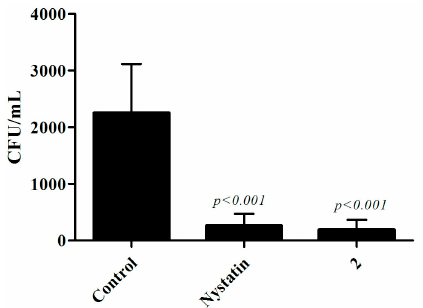
Figure 6. Murine model treatment of oral candidiasis. The number of colony-forming units (CFU) recovered from the tongues of C57BL/6 females infected with C. albicans CAN14 was lower in the nystatin (600 IU) and thiazolylhydrazone derivative 2 (100 mg/kg) treated animals than in the untreated control group (Newman-Keuls Multiple Comparison test).